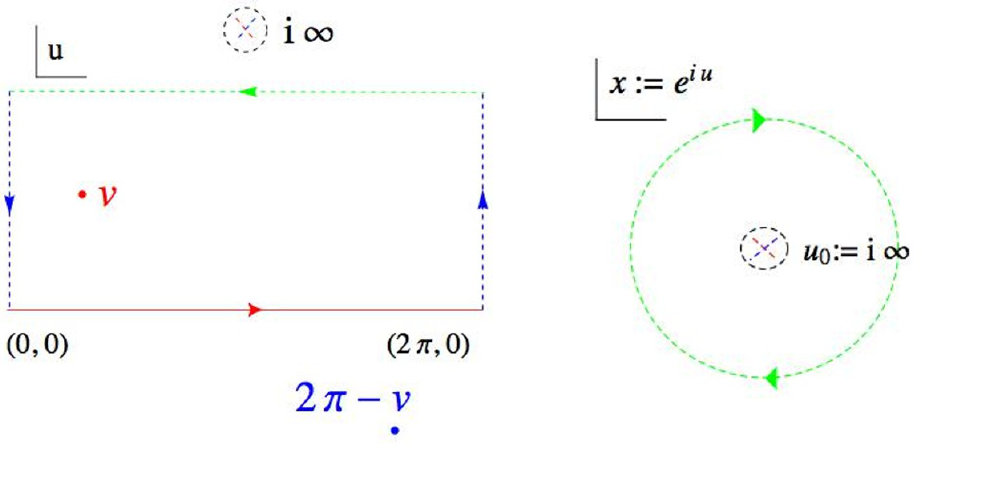
Figure 3 . The integration path to use in the u complex plane is depicted in red in the (cid:12)gure above. The red (blue) point represents the pole associated with positively (negatively) charged matter multiplets. The position of these poles is determined by the (cid:13)avour Wilson line along S 1 that we denote as v . These poles have images that repeat with period 2 (cid:25) Z . The integration along the two disconnected blue lines cancel out each other. The map x := e iu sends the green line in the left to the S 1 contour in the right, that encloses only the potential pole at the origin x = 0( u = i 1 ). The integration along the green line equates then to the residue at the point x = 0 ( u = i 1 ). The red line maps to the circumference of unit radius. The circumference of unit radius will enclose not only the pole at x = 0 but also the poles associated to the presence of matter multiplets, namely the image of the red point in the (cid:12)gure in the